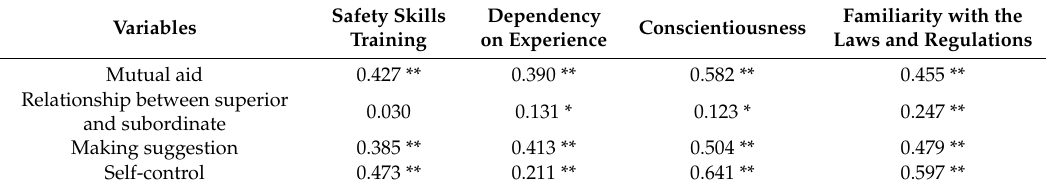
Table 11. Pearson correlation coe ffi cient between each